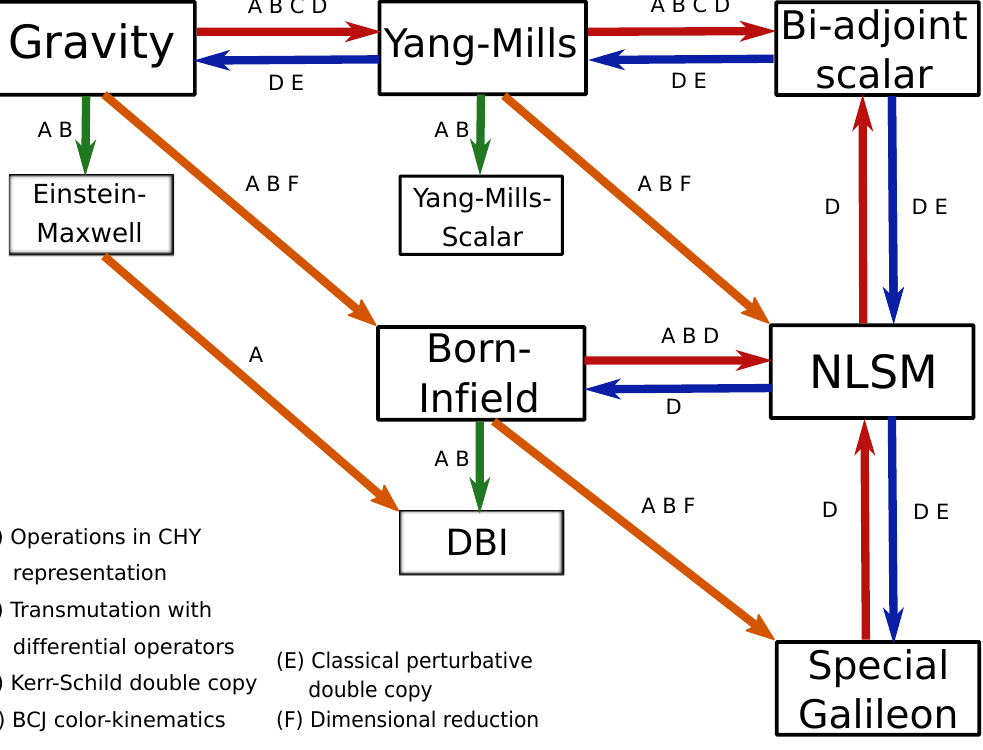
Figure 1 . Web of relationships between various (cid:12)eld theories. The operations in CHY representa- tion correspond to those in [31] and the transmutations with di(cid:11)erential operators are given in